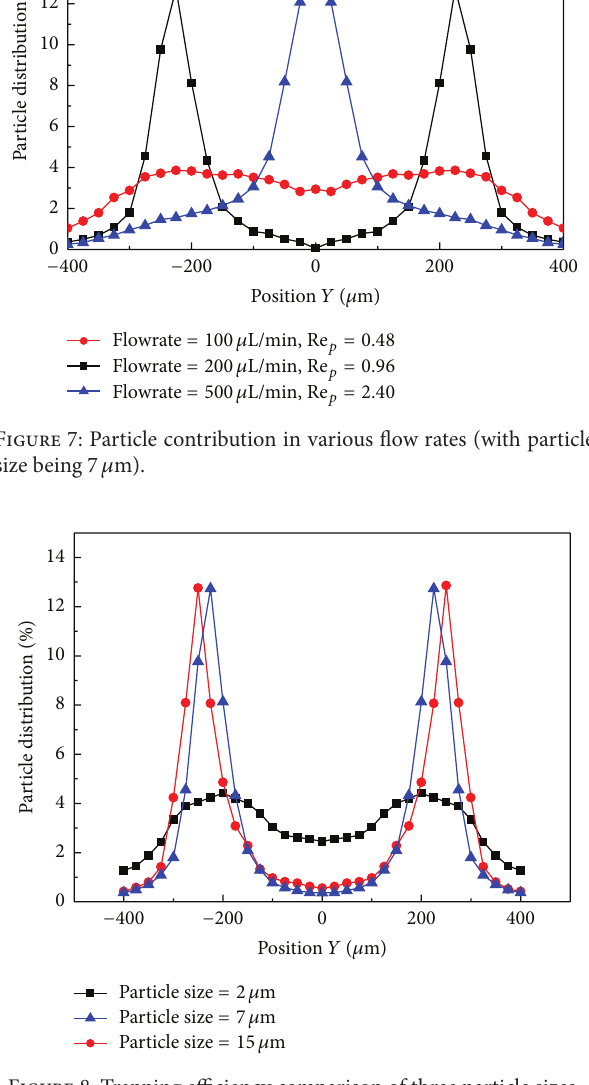
Figure 8: Trapping efficiency comparison of three particle sizes.